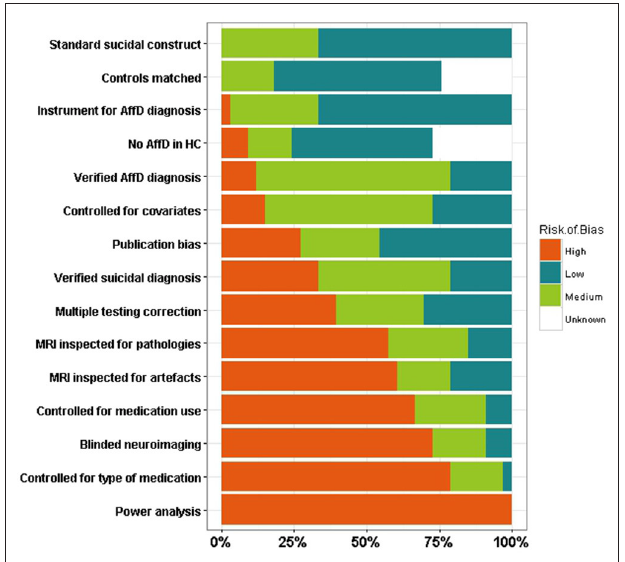
FIGURE 3 | Risk of bias assessment. Stacked bars representing the percentage of literature papers identified at a high, medium, low, or unknown risk of bias for specific possible sources of bias. AffD, affective disorder; MRI, magnetic resonance imaging; HC, healthy controls.